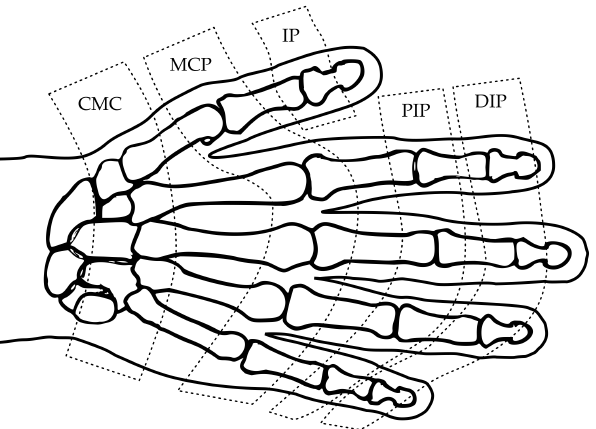
Figure 18. Basic nomenclature for the hand articulations, with Distal (D-) and proximal (P-) inter-phalangeal (IP) articulations, and metacarpo-phalangeal (MCP) and carpo-metacarpal (CMC)